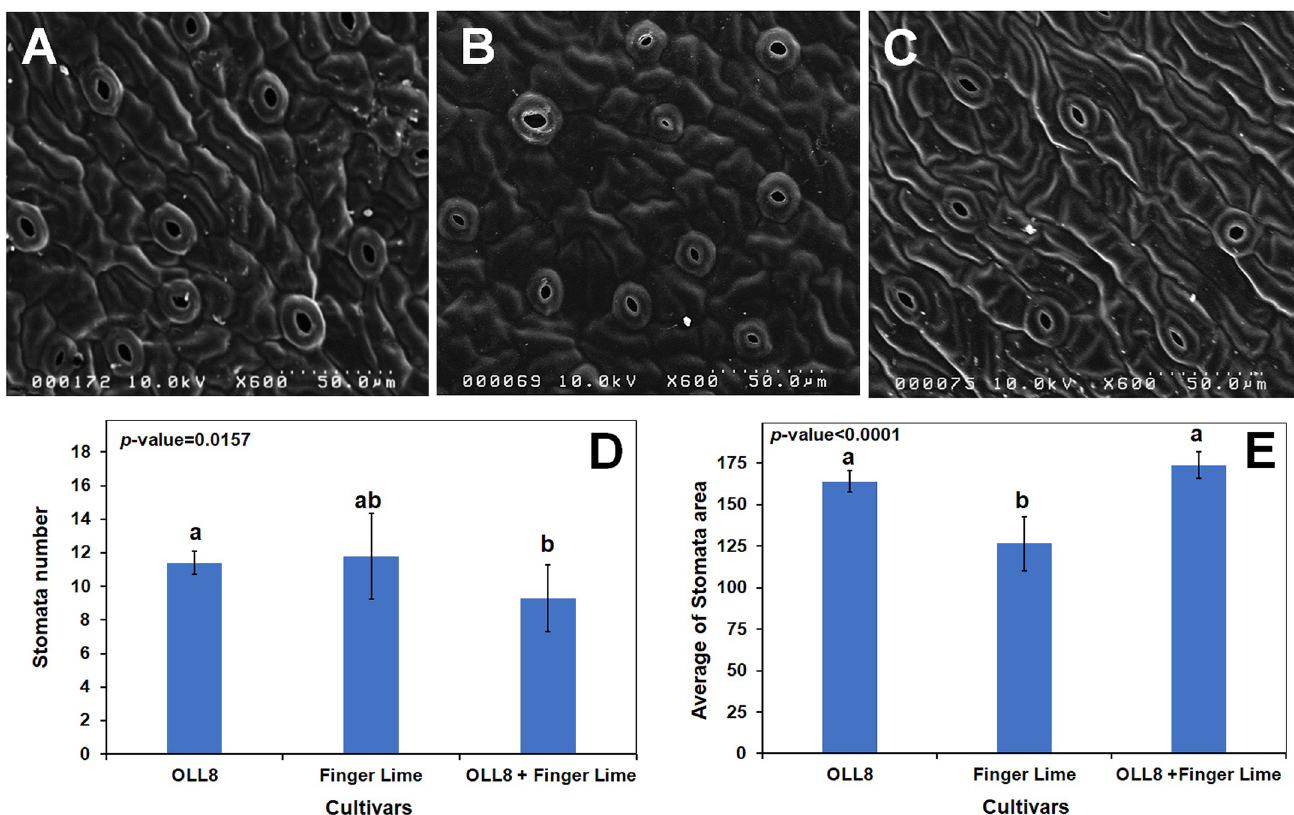
Fig 2. Stomatal trait analysis in diploid and tetraploid finger lime leaves. Top panel (A-C) are Scanning Electron Microscopy (SEM) images demonstrating differences in stomata numbers in A) OLL8, (B) finger lime and a (C) tetraploid somatic fusion. Lower panel are bar graphs comparing stomata number (D) and average stomatal area (E) in diploid parents and the tetraploid somatic fusion.